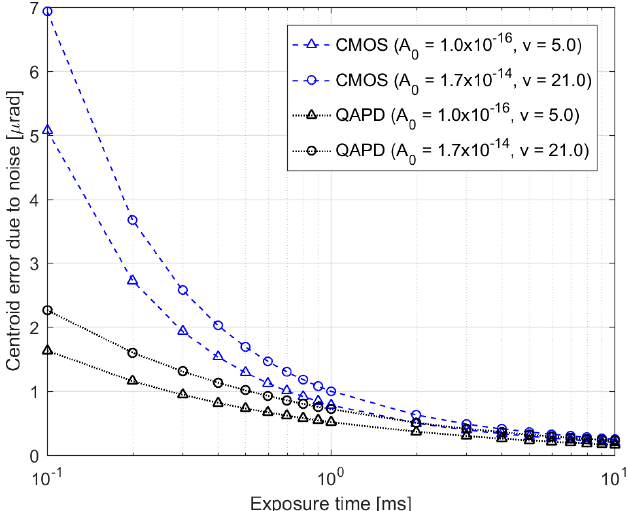
Figure 3. Average centroid error due to noise sources versus exposure time under two atmospheric turbulence conditions.